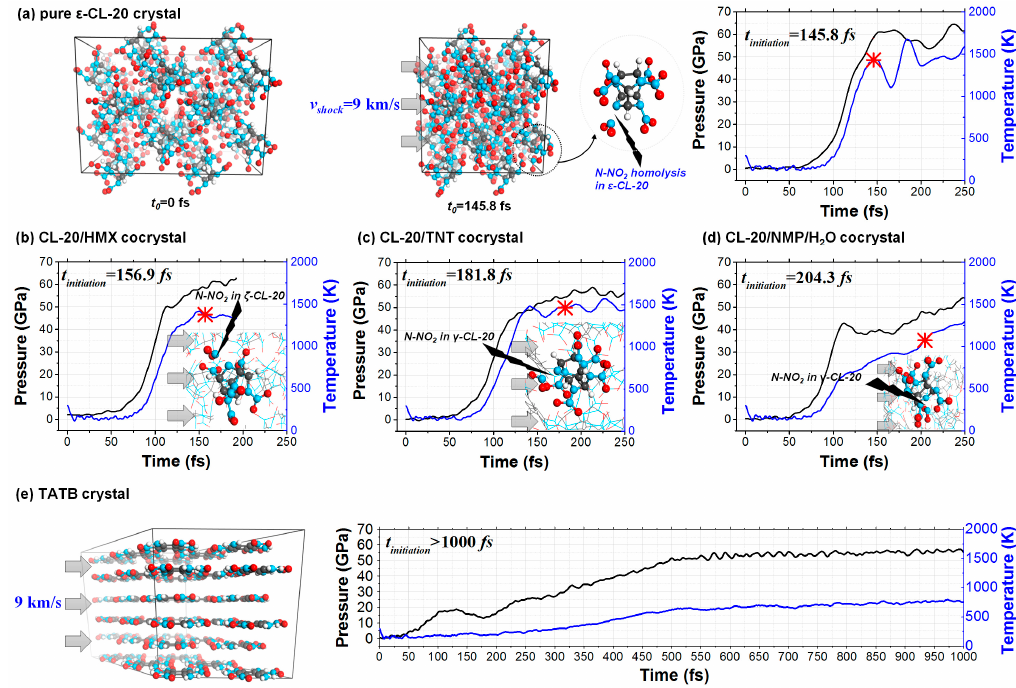
Figure 2. Shock dynamics of the ( a ) ε -CL-20 crystal, ( b ) CL-20 / HMX cocrystal, ( c ) CL-20 / TNT cocrystal, ( d ) CL-20 / NMP / H 2 O cocrystal and ( e ) TATB crystal. In each panel, the temperature and pressure are shown as a function of time. The molecular conformations at the beginning of each decomposition reaction are also plotted.